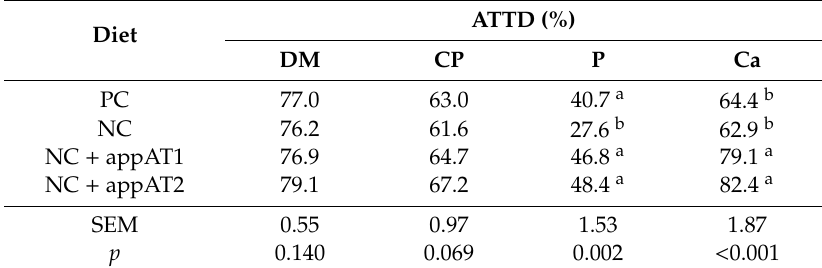
Table 5. Apparent total tract digestibility (ATTD in %) of the dry matter (DM), crude protein (CP), P, and Ca of piglets fed the positive control (PC), negative control (NC), and NC diets supplemented with phytase (appAT1 or appAT2), (n = 12). ATTD Diet